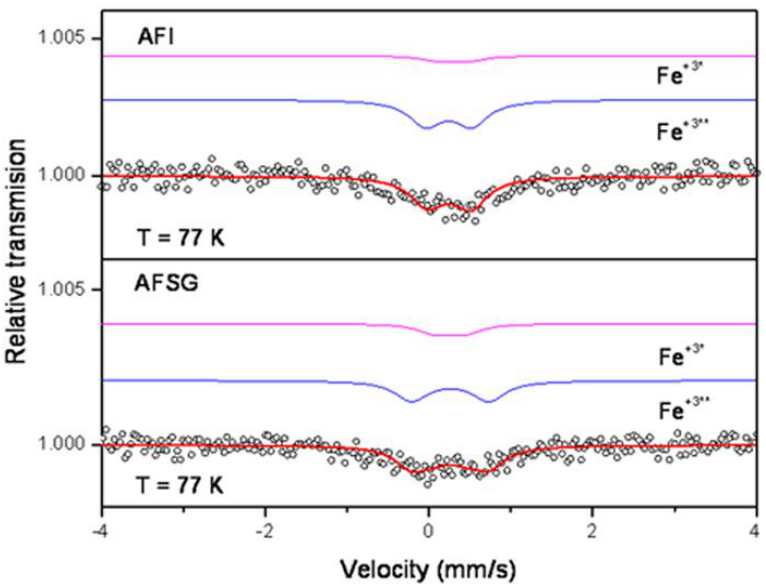
Figure 9. Mössbauer spectra at 77 K for ( a ) AFI and ( b )